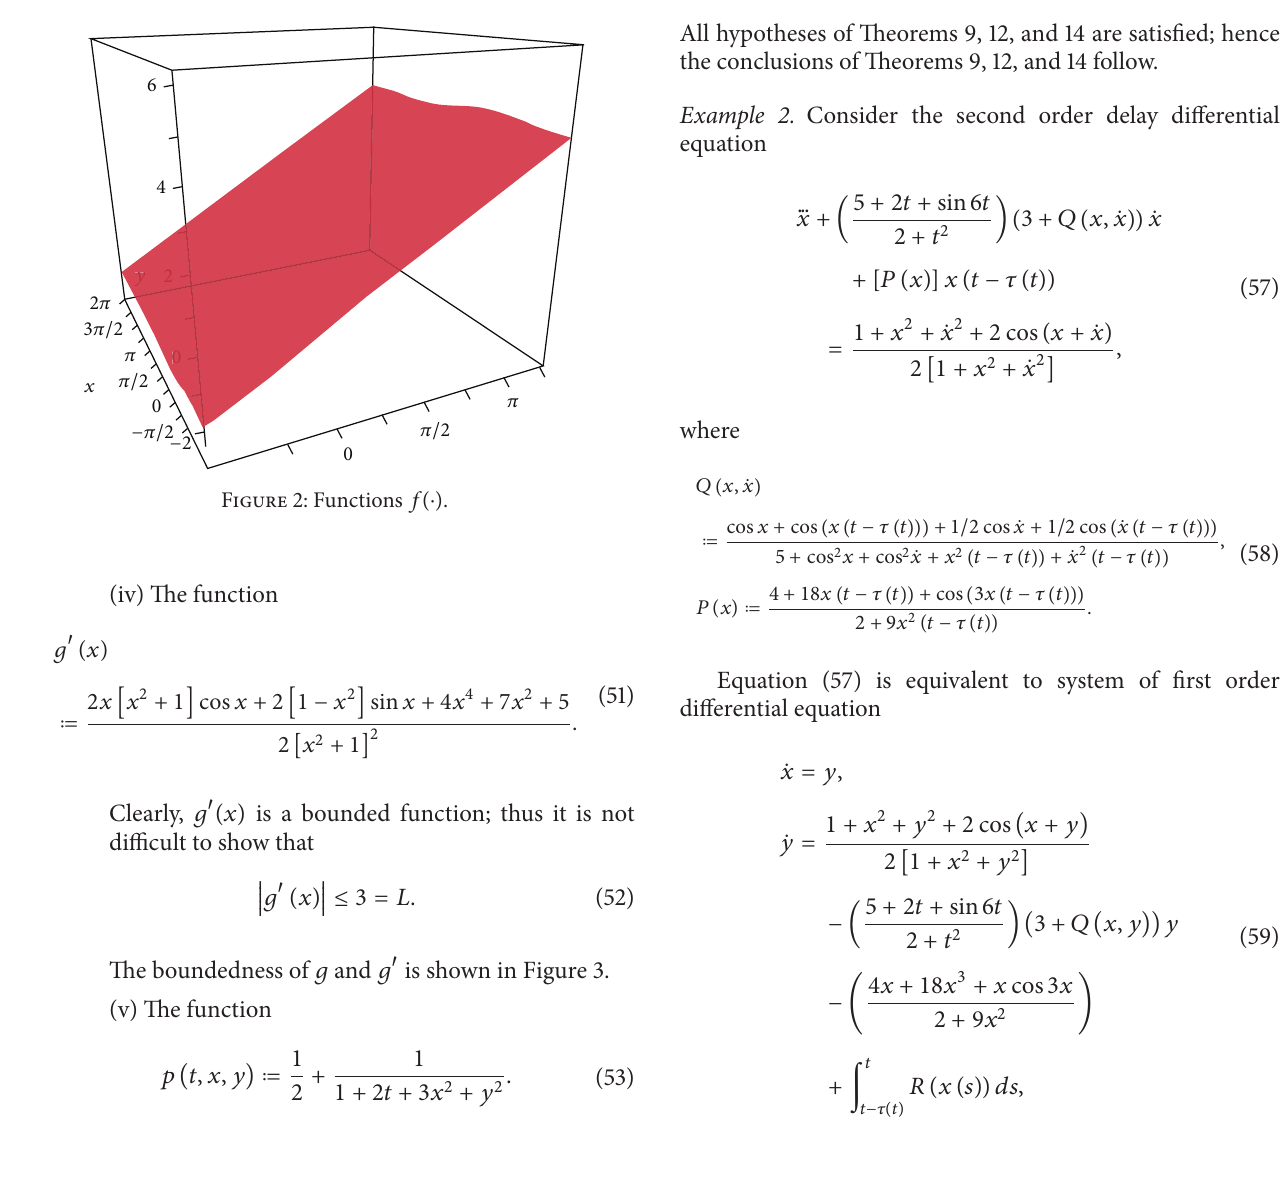
Figure 1: Functions 𝜙(𝑡) .